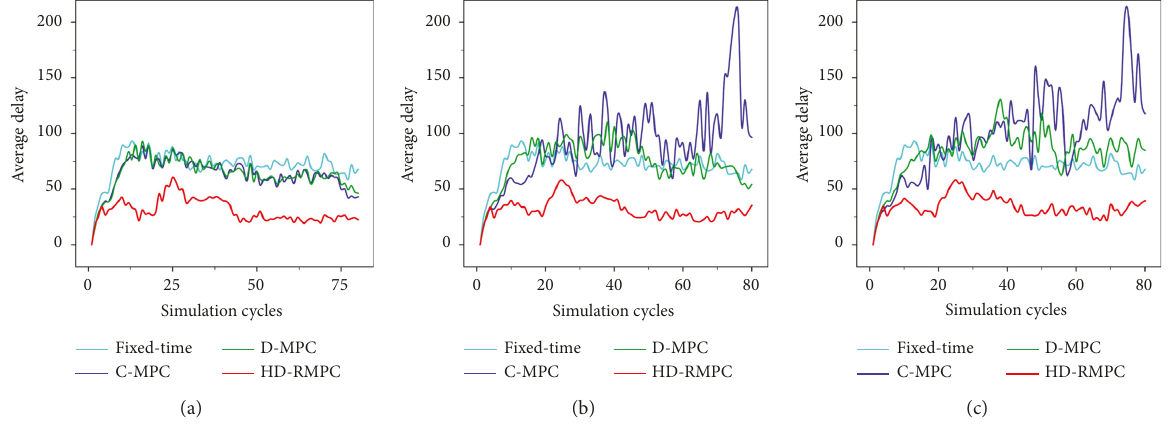
� 1. (b) N � 2. (c) N � p p p